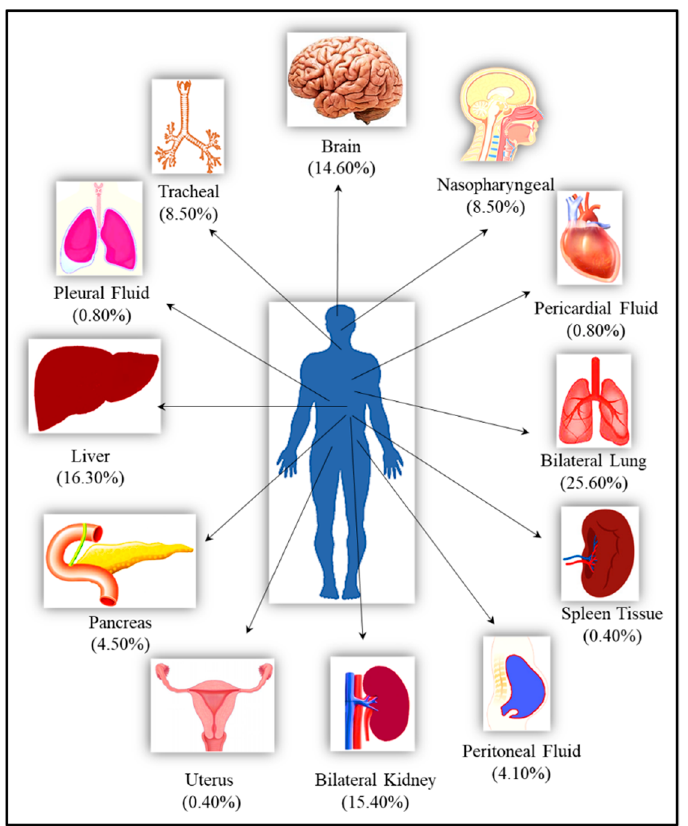
Figure 1. The list of the organs from the autopsied bodies along with their percentage representation in the total studied samples.